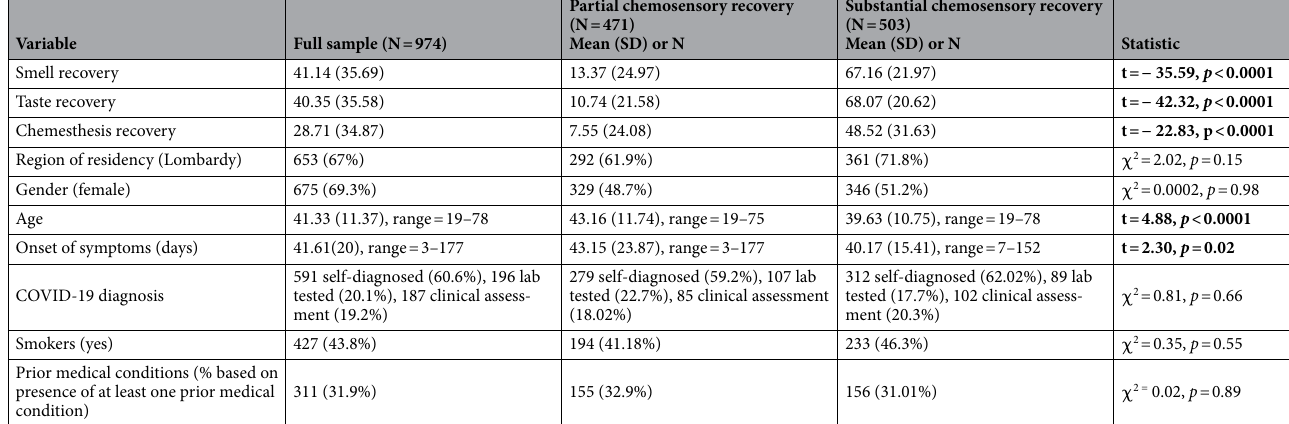
Table 1. Characteristics of the total sample and the clusters based on chemosensory recovery. Significant differences between the two recovery groups are marked in bold.